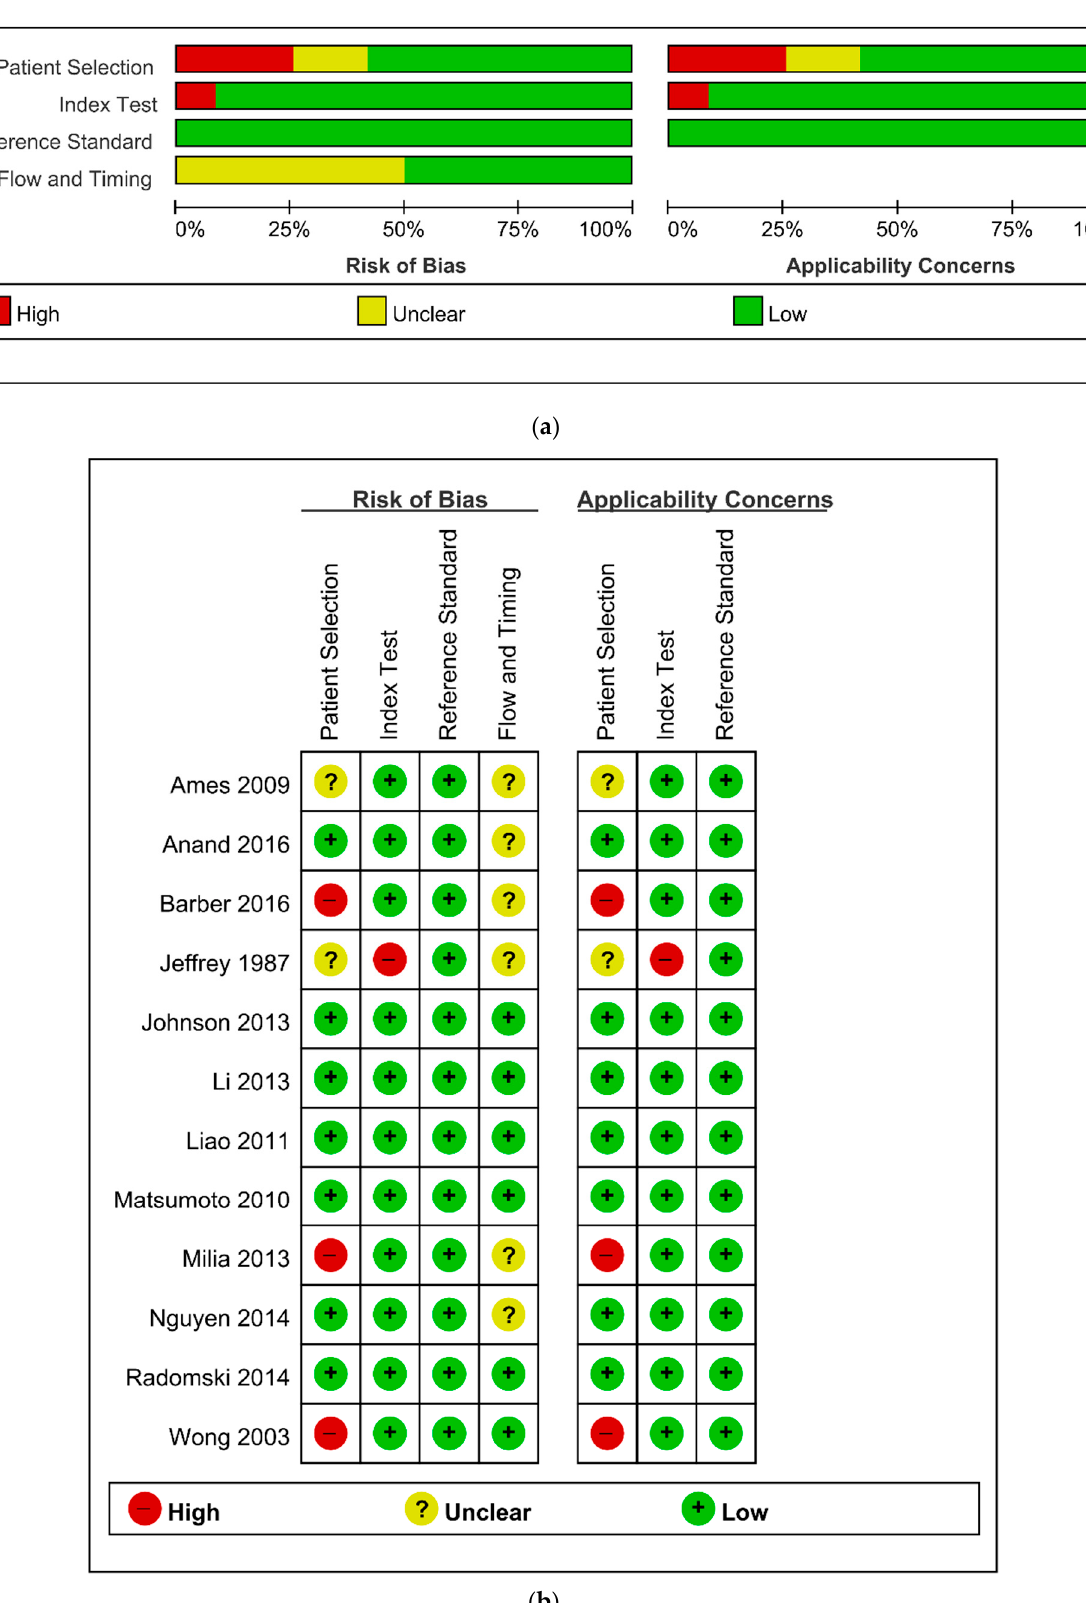
Figure 2. Risk of bias and applicability concerns graph ( a ) and summary ( b ): review authors’ judge- ments about each domain presented as percentages across included studies [15–17,22,23,25,26].